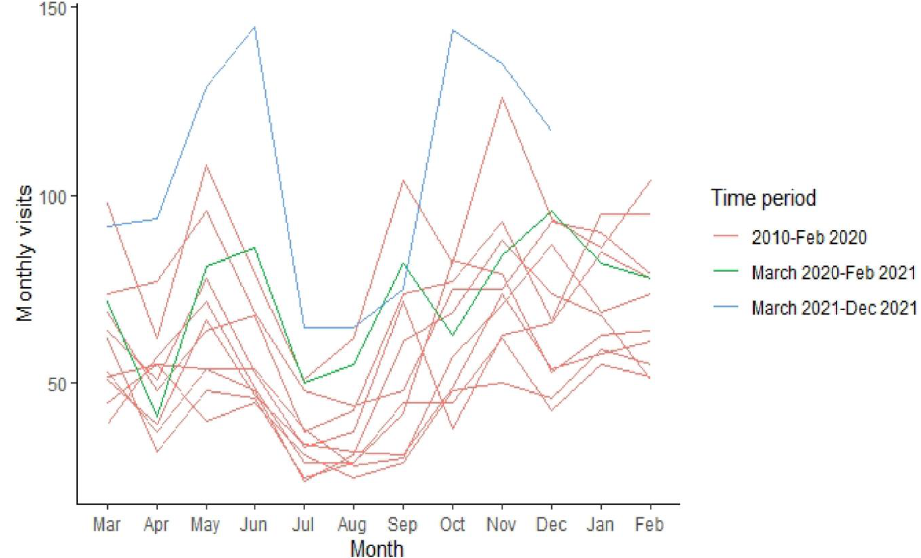
Figure 2. ER referrals between the years 2010 – 2021. Lines represent separate